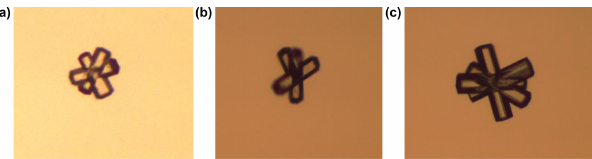
Figure 1. Microscope images of sodium fluorosilicate crystals that were used as analogues for ice crystals. These are referred to as ROS118 (a) , ROS250 (b) , and ROS300 (c)